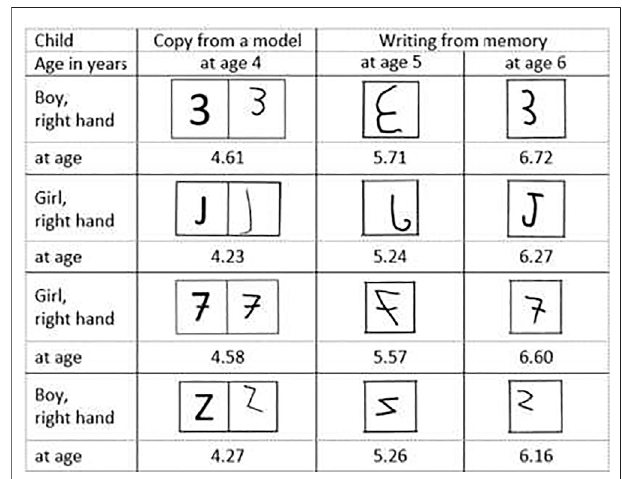
FIGURE1| Characterscorrectlycopiedatagefour,mirrorwrittenatage fi ve, and correctly written at age six by the same children (data from Fischer and Koch,